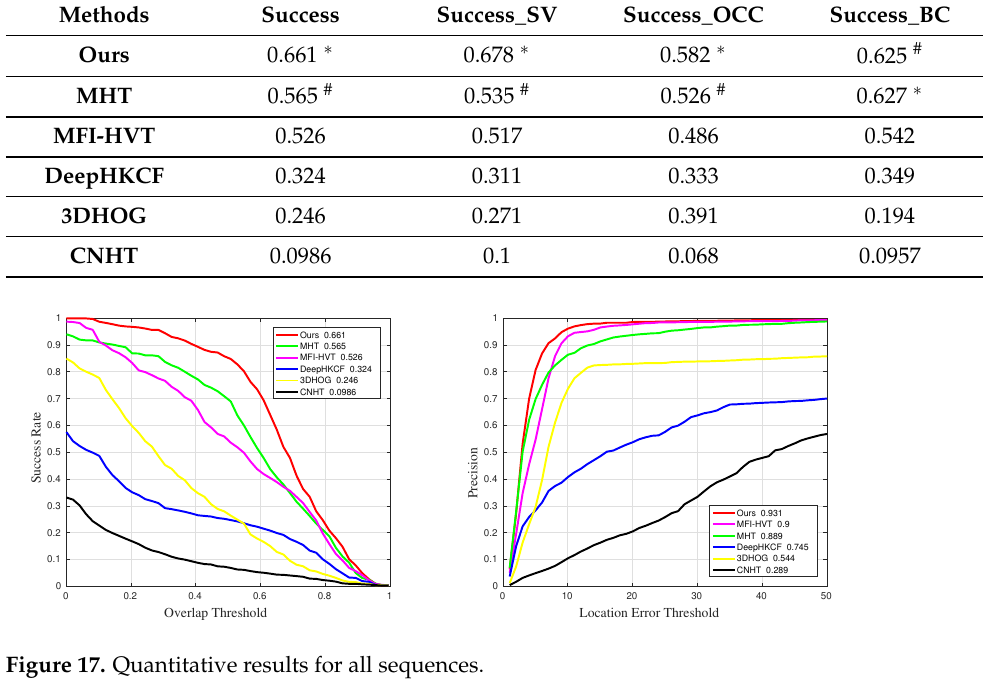
Figure 17. Quantitative results for all sequences.